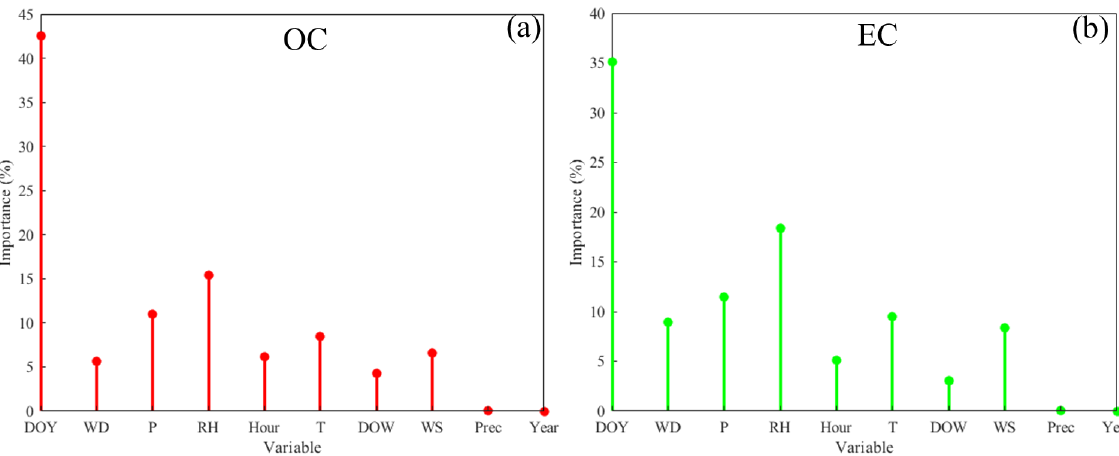
Figure 10. Relative importance of the predictors for the prediction of OC and EC in PM 2 . 5 . The match in the figure denotes the variable importance in RF models for various species. DOY, WD, P , RH, Hour, T , DOW, WS, Prec, and Year represent day of year, wind direction,